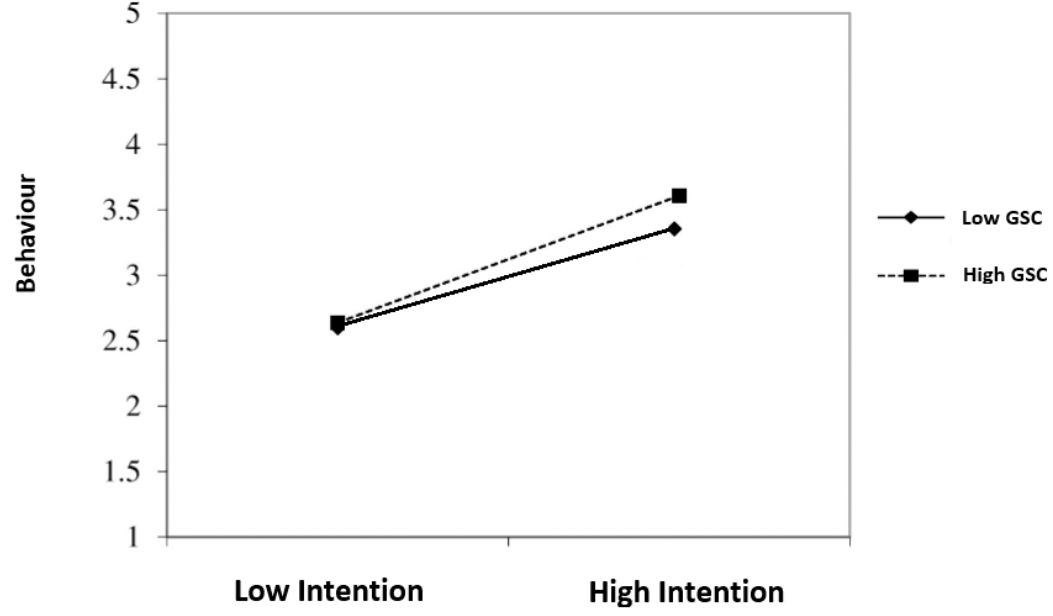
Figure 3. Moderation plot GSC (green psychological